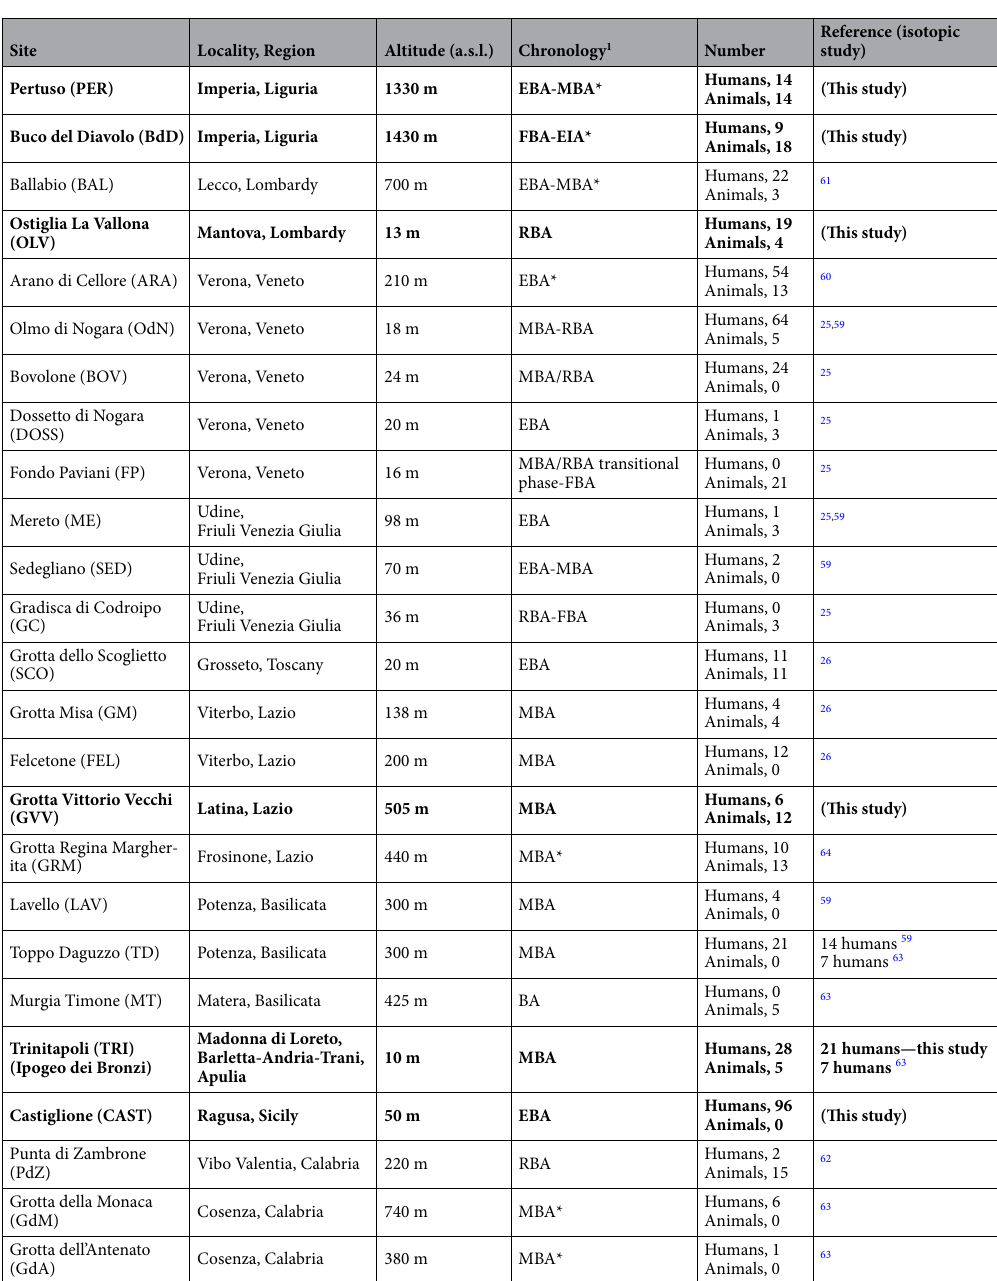
Table 1. Bronze Age Italian sites included in this overview. In bold the new sites presented in this study. 1 The chronology refers to radiocarbon dating (*). When absent, it refers to dating based on archaeological materials. Supplementary Information 1 for the relevant references. EBA Early Bronze Age (ca. 2200–1650 BC), MBA Middle Bronze Age (ca. 1650–1350/1300 BC), RBA Recent Bronze Age (ca. 1350/1300–1150 BC), FBA Final Bronze Age (ca. 1150–950/925